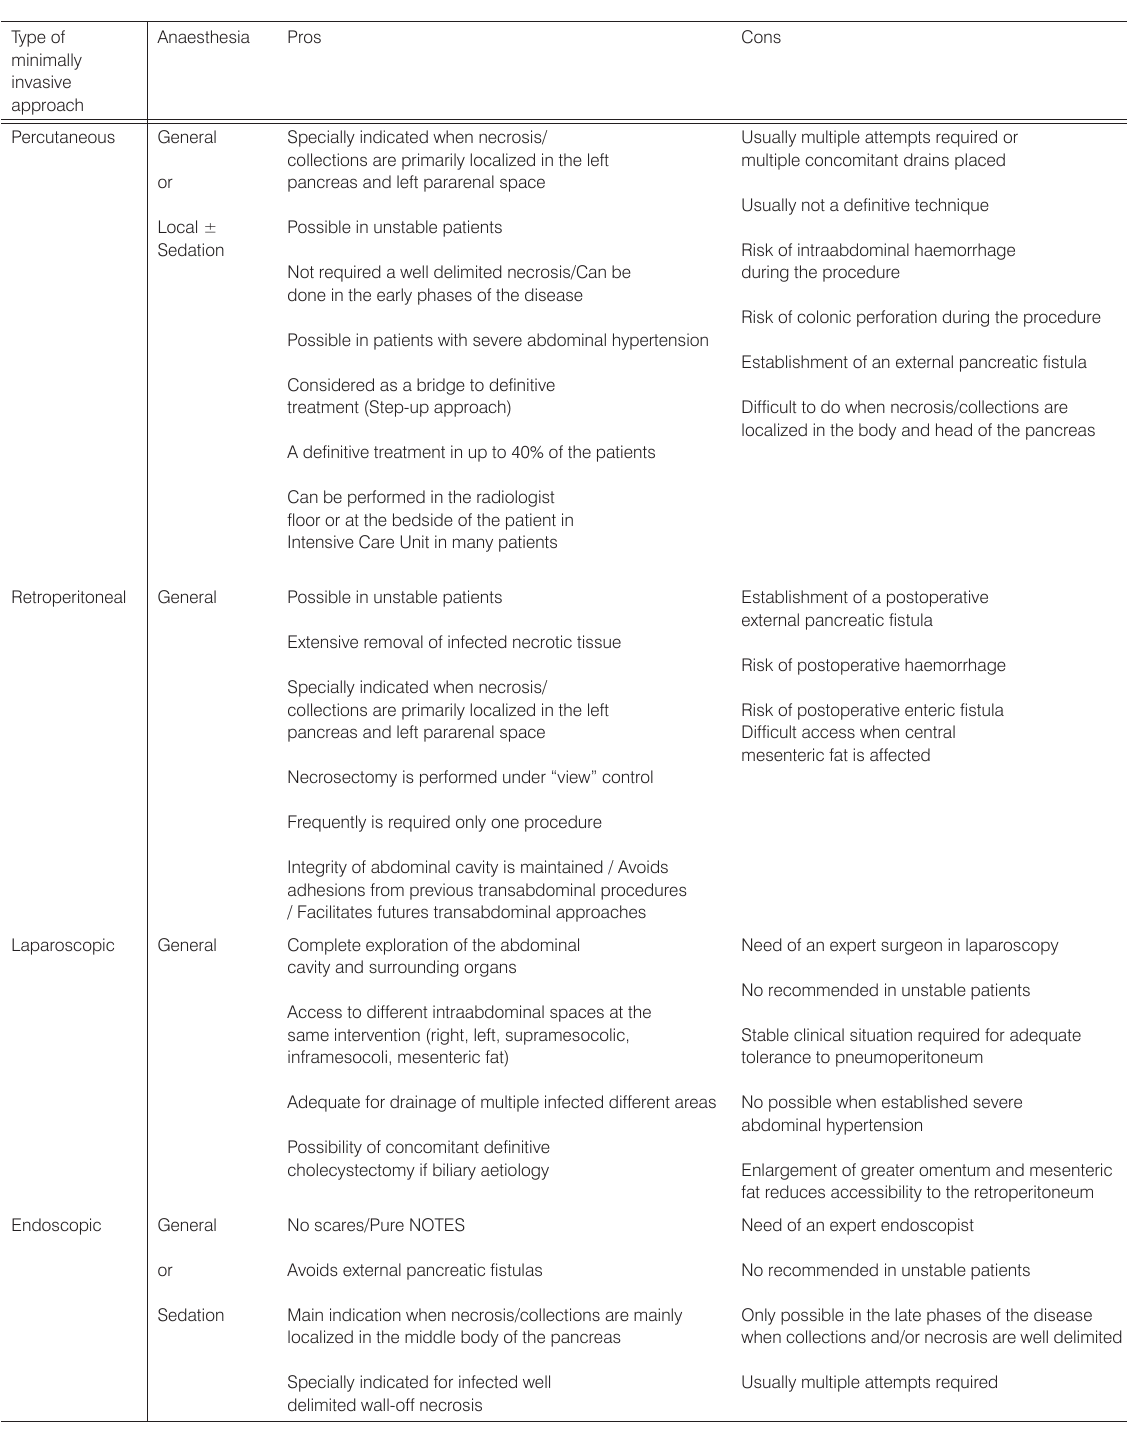
Table 1. Possible advantages and disadvantages of different minimally invasive approaches in severe acute